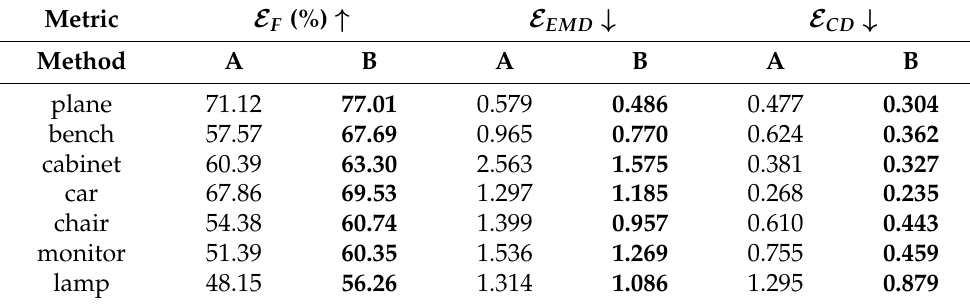
Table 7. Comparison of ( A ) Pixel2Mesh [7] and ( B ) VANet [9] on the Choy et al. [18] subset of the ShapeNet dataset [10]. VANet outperforms Pixel2Mesh in all metrics, with 10–40% improvement. Bold values show the best results for each